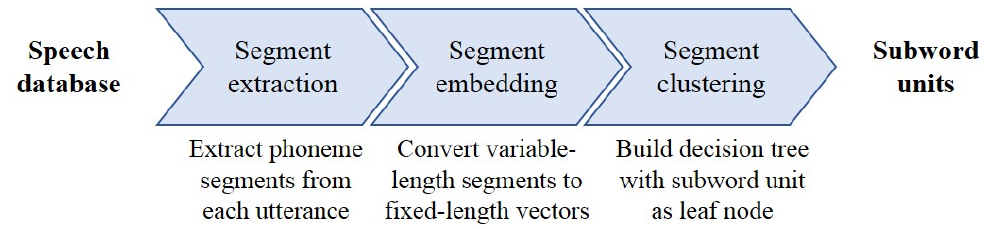
Figure 1. Framework for building the proposed unit using segment embedding and clustering.